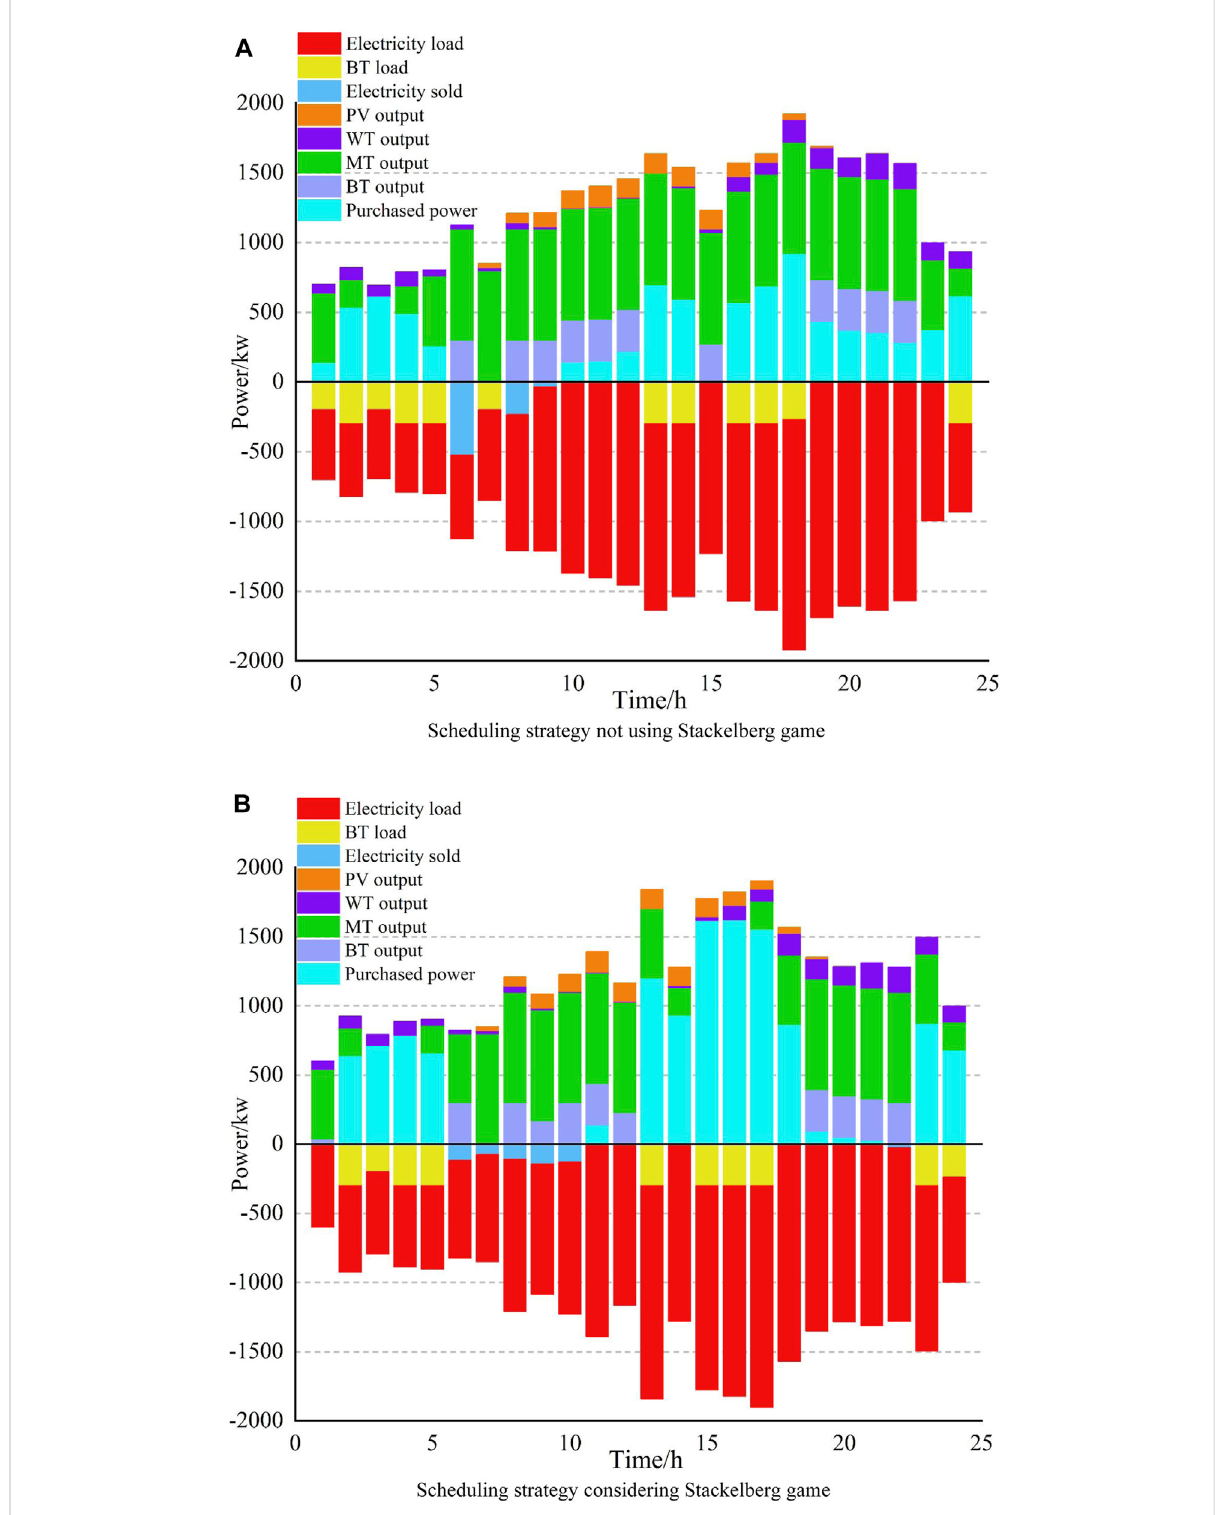
FIGURE 6 Case 1: the power of each subject under different strategies. (A) Scheduling strategy not using Stackelberg game. (B) Scheduling strategy considering Stackelberg